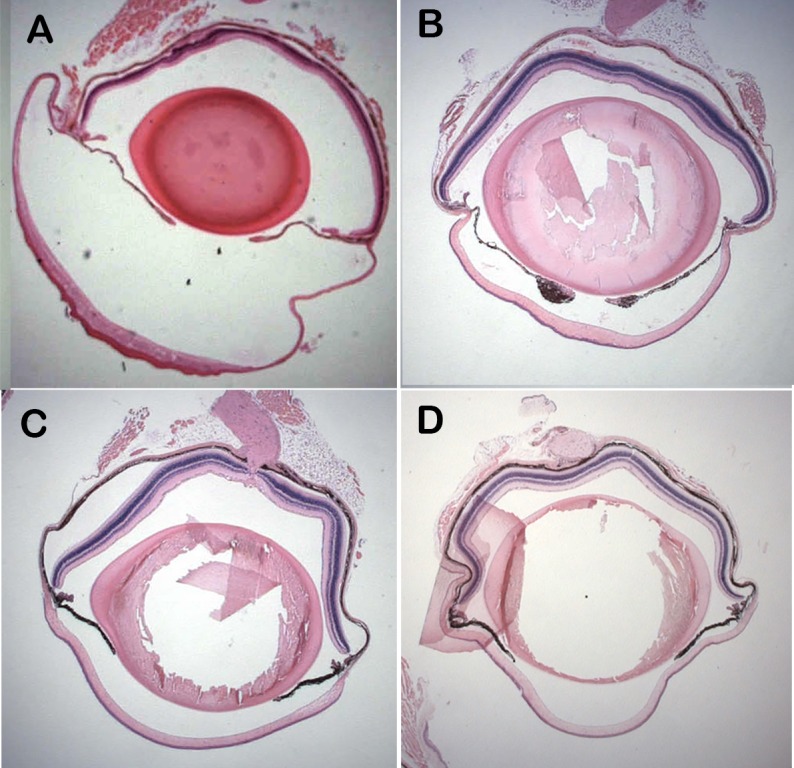
Lack of anterior chamber enlargement in Csrp2bpEx/+ and Csrp2bpEx/Dzank1tm1a double heterozygous mice.(A) PPCD1/D2 mouse, age 3 weeks. (B) Csrp2bpEx/+ mouse, age 8 months. (C) Csrp2bpEx/Dzank1tm1a double heterozygote, (D2xB6 F1 background), age 5 months. (D) Wildtype B6 mouse, age 5 months. Magnification 12.5X.